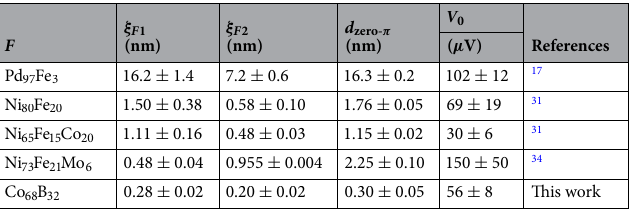
Table 1. Best fit parameters determined for selected S − F − S Josephson junctions where the F layers are ferromagnetic alloys and the I c R N oscillations are well described by Eq.